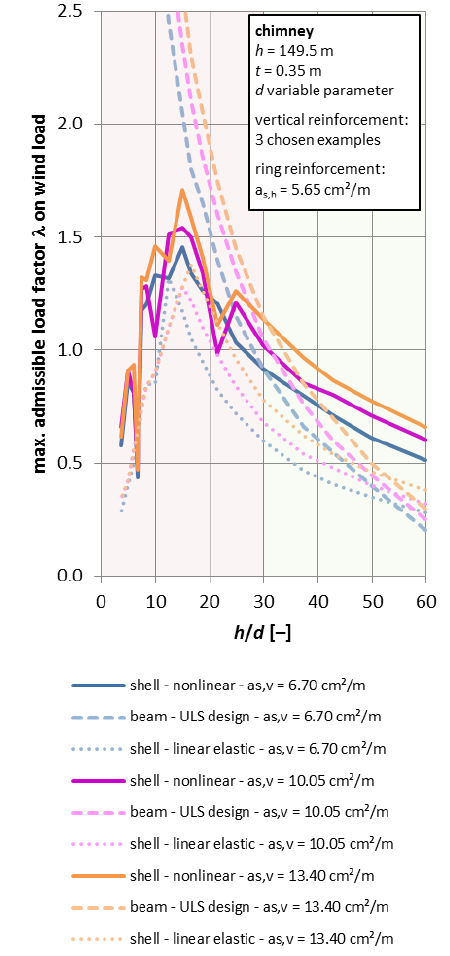
Figure 8. Comparison of meridional forces acc. to beam and shell design with respect to different ratios h/d